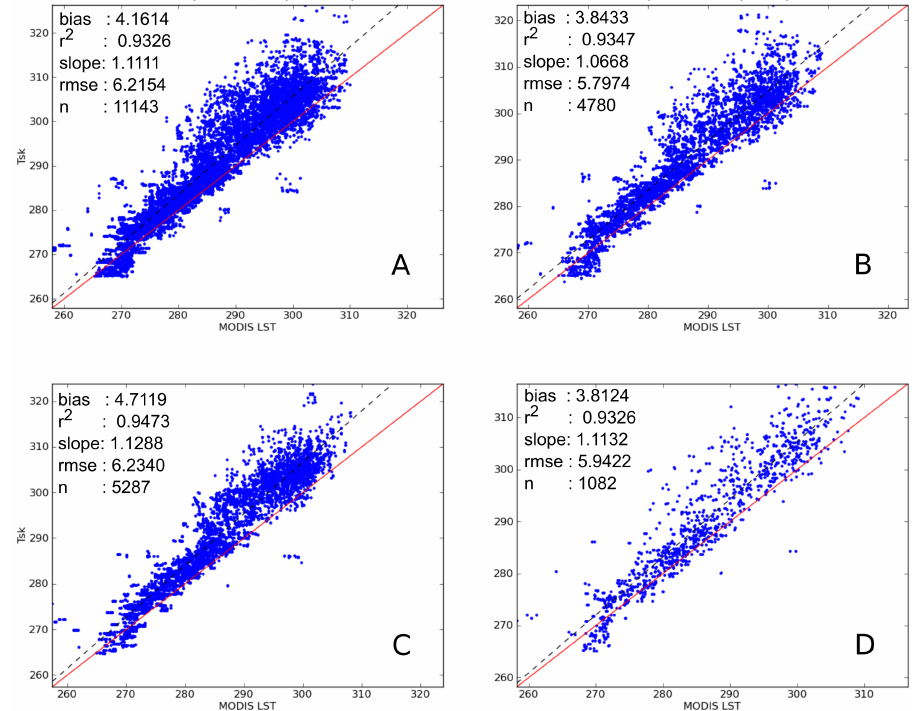
Figure 8. Scatterplots of MODIS LST and the skin temperature ( T sk ) internally estimated by the model. ( A ) Crops; ( B ) pastures; ( C ) wetlands; ( D ) complex cultivation